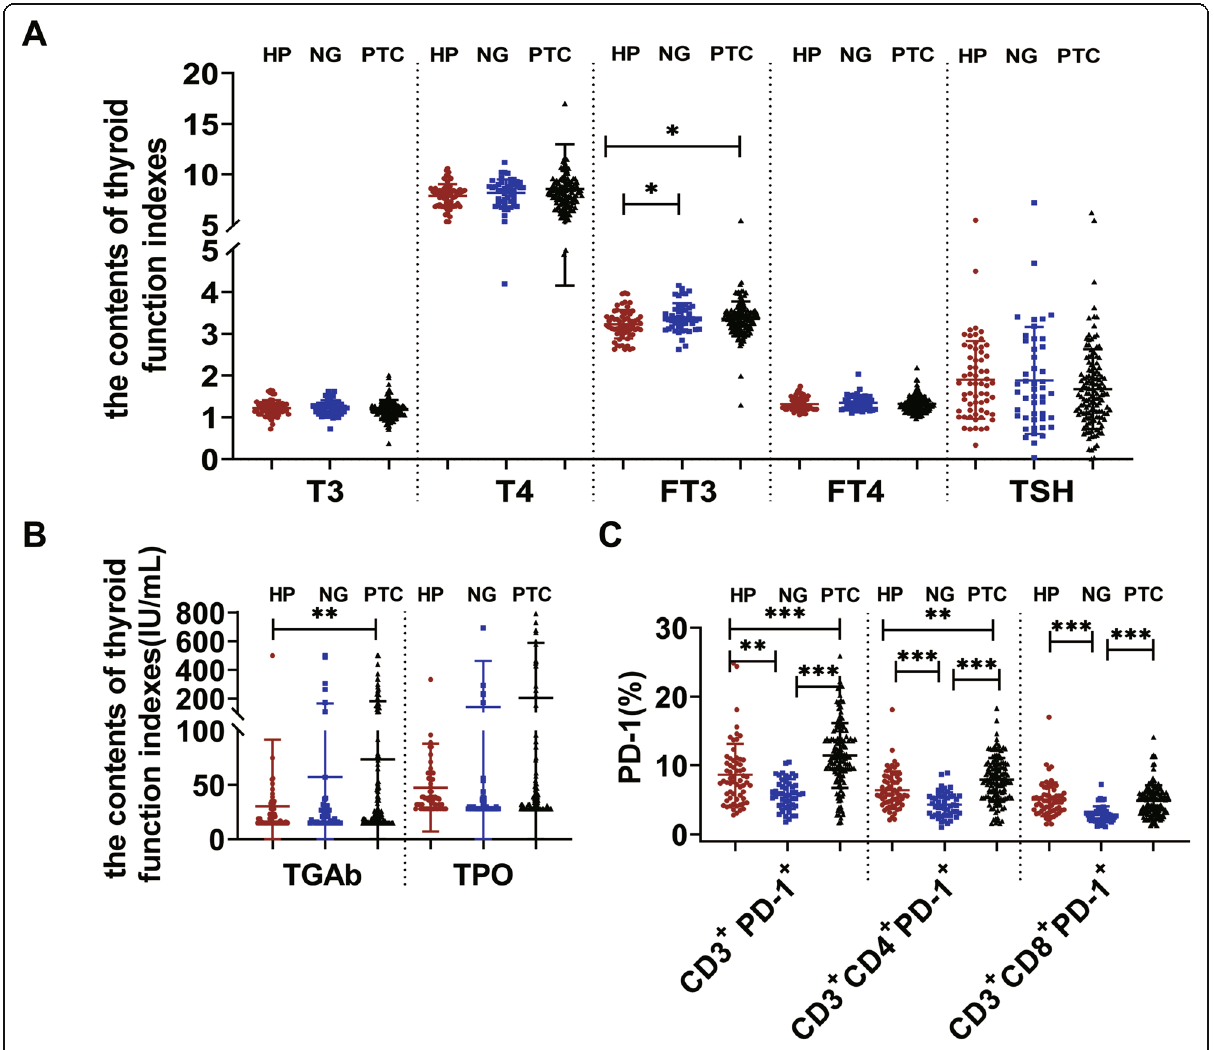
Fig. 1 The activities of thyroid function indexes and PD-1. A. The plasma activities of the T3, T4, FT3, FT4, TSH among PTC, NG and HP groups. B. The plasma activities of the TGAb and TPO among PTC, NG and HP groups. C. The activities of the CD3 + PD-1 + , CD3 + CD4 + PD-1 + and CD3 + CD8 + PD-1+ among PTC, NG and HP groups (* P < 0.05), P < 0.05 represents a significant